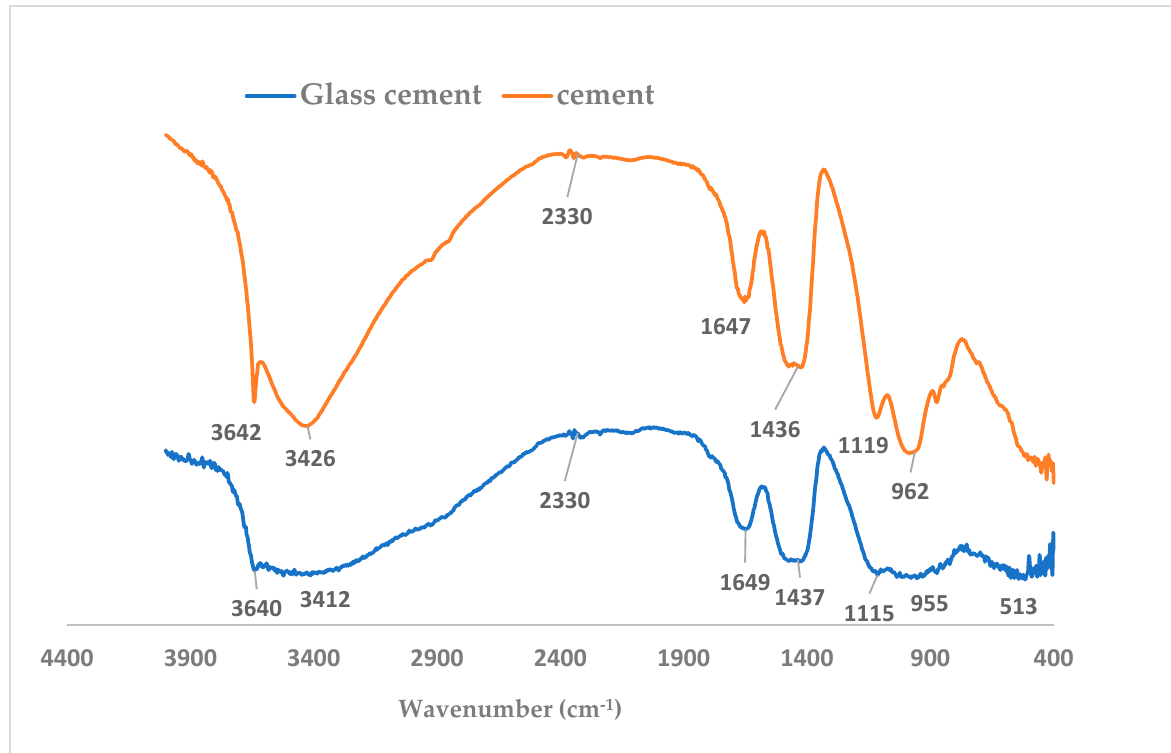
Figure 14. FTIR spectra of glass blended and hydrated cement mortar.